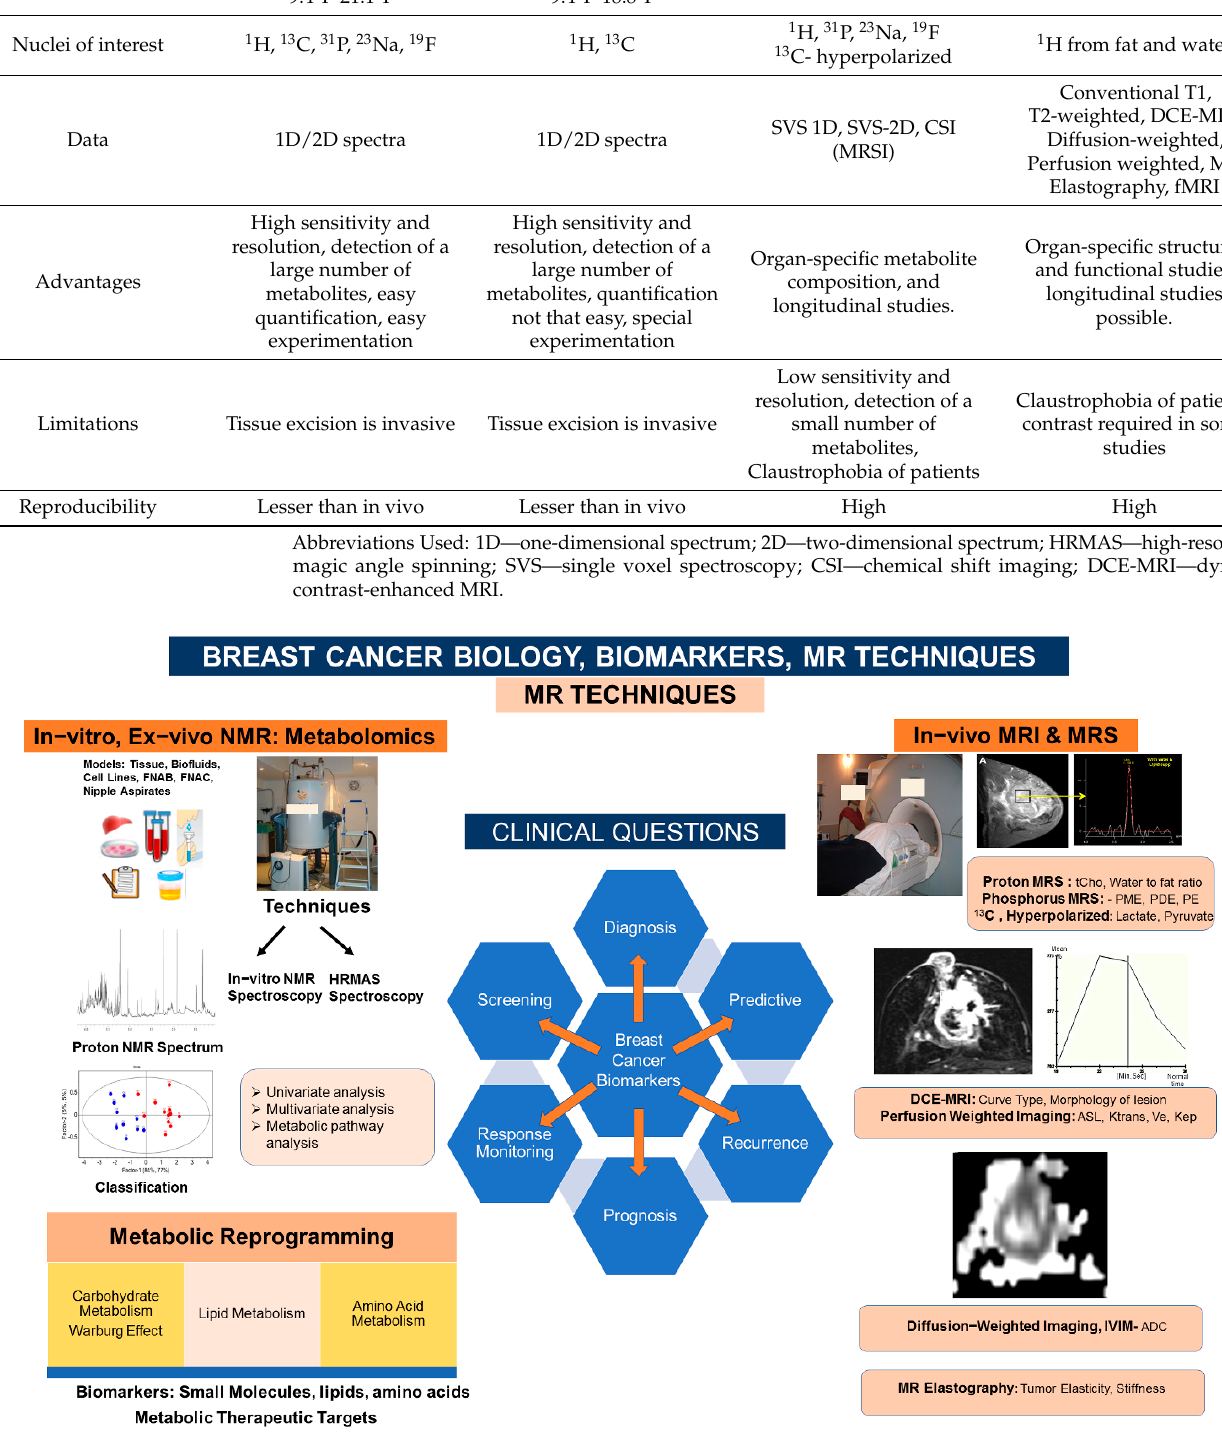
Figure 1. Schematic representation of various MRI and MRS techniques and biomarkers obtained in studying breast cancer biology and metabolism. Table 1. Comparison of in vitro, ex vivo, and in vivo magnetic resonance spectroscopy (MRS) and MRI techniques.